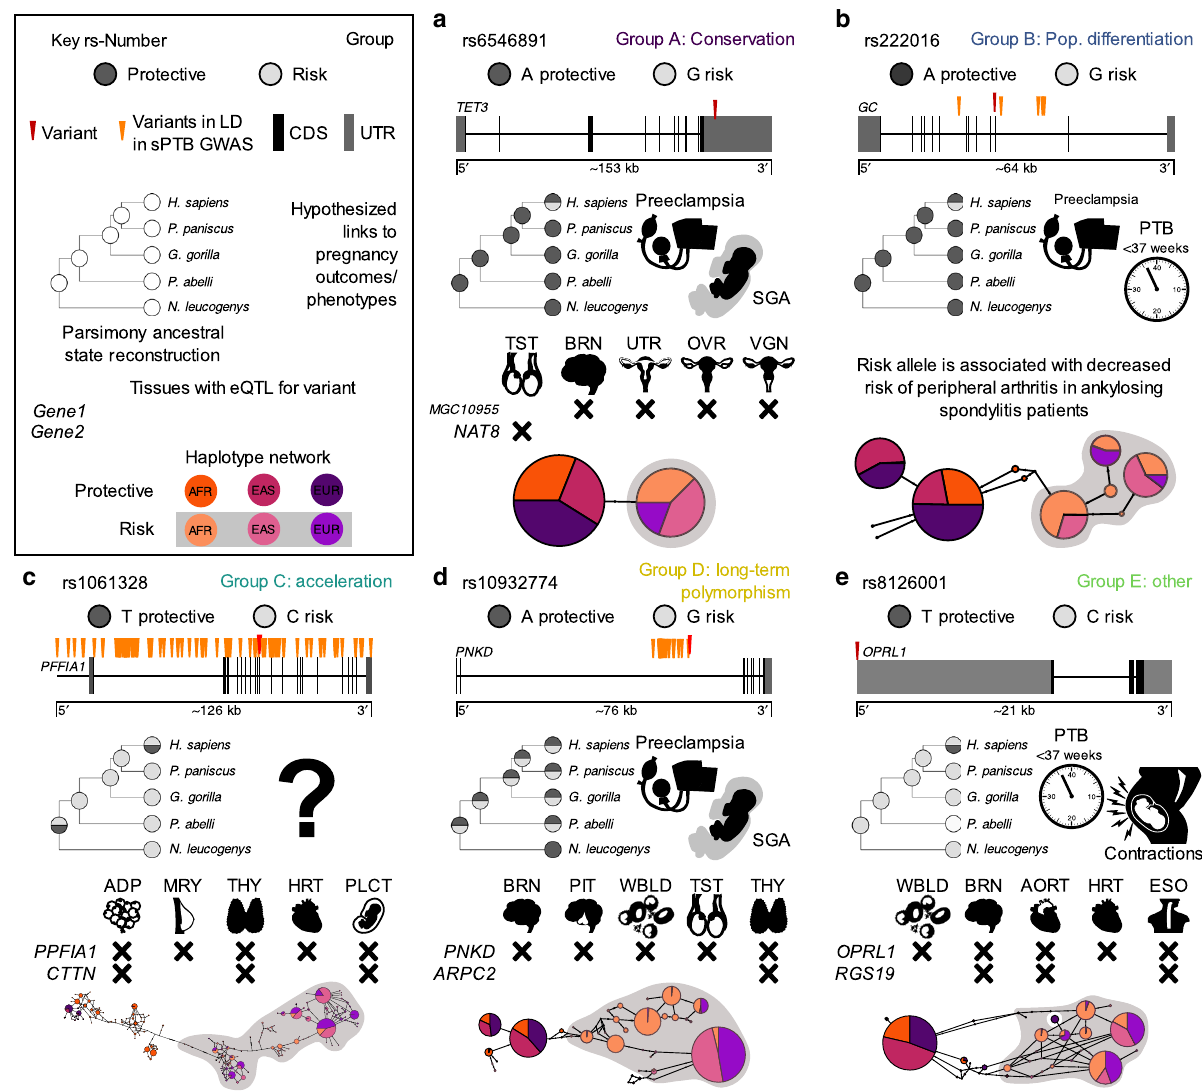
Fig. 4 Functional and evolutionary characterizations of sPTB-associated genomic regions. For each variant we report the protective and risk alleles from the sPTB GWAS 107 ; the location relative to the nearest gene and linked variants; the alleles at this variant across the great apes and the parsimony reconstruction of the ancestral allele(s); hypothesized links to pregnancy outcomes or phenotypes; selected signi fi cant GTEx hits; and human haplotype(s) containing each variant in a haplotype map. a Group A (conservation): Human-speci fi c risk allele of rs6546894 is located in the 3 ’ UTR of TET3 . TET3 expression is elevated in preeclamptic and small for gestational age (SGA) placentas 46 . rs6546894 is also associated with expression of MGC10955 and NAT8 in the testis (TST), brain (BRN), uterus (UTR), ovaries (OVR), and vagina (VGN). b Group B (population differentiation): rs222016, an intronic variant in gene GC , has a human-speci fi c protective allele. GC is associated with sPTB 44 . c Group C (acceleration): rs1061328 is located in a PPFIA1 intron and is in LD with 156 variants. The protective allele is human-speci fi c. This variant is associated with changes in expression of PPFIA1 and CTTN in adipose cells (ADP), mammary tissue (MRY), the thyroid (THY), and heart (HRT). CTTN is expressed the placenta 63,108 . d Group D (long-term polymorphism): rs10932774 is located in a PNKD intron and is in LD with 27 variants. Alleles of the variant are found throughout the great apes. PNKD is upregulated in severely preeclamptic placentas 69 and ARPC2 has been associated with SGA 109 . Expression changes associated with this variant include PNKD and ARPC2 in the brain, pituitary gland (PIT), whole blood (WBLD), testis, and thyroid. e Group E (other): rs8126001 is located in the 5 ’ UTR of OPRL1 and has a human-speci fi c protective allele. The protein product of the ORPL1 gene is the nociceptin receptor, which is linked to contractions and the presence of nociception in preterm uterus samples 78,79 . This variant is associated with expression of OPRL1 and RGS19 in whole blood, the brain, aorta (AORT), heart, and esophagus